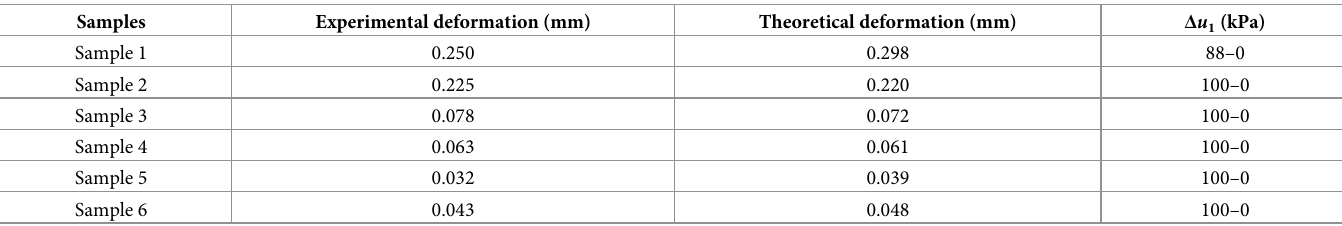
Table 5. Comparison of experimental and theoretical